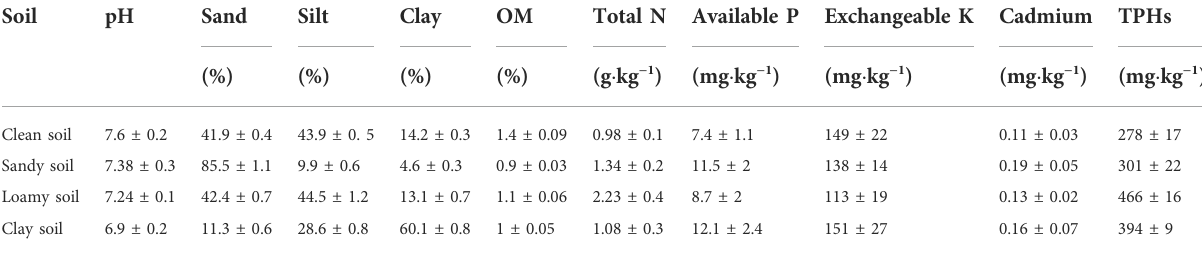
TABLE 1 Physico-chemical characteristics of experimental soils (0 – 30 cm), including pH, Sand, Silt, Clay, Organic Matter (OM), Total Nitrogen (Total N), Available Phosphorus (Available P), Exchangeable Potassium (Exchangeable K), Cadmium and Total Petroleum Hydrocarbons (TPHs).